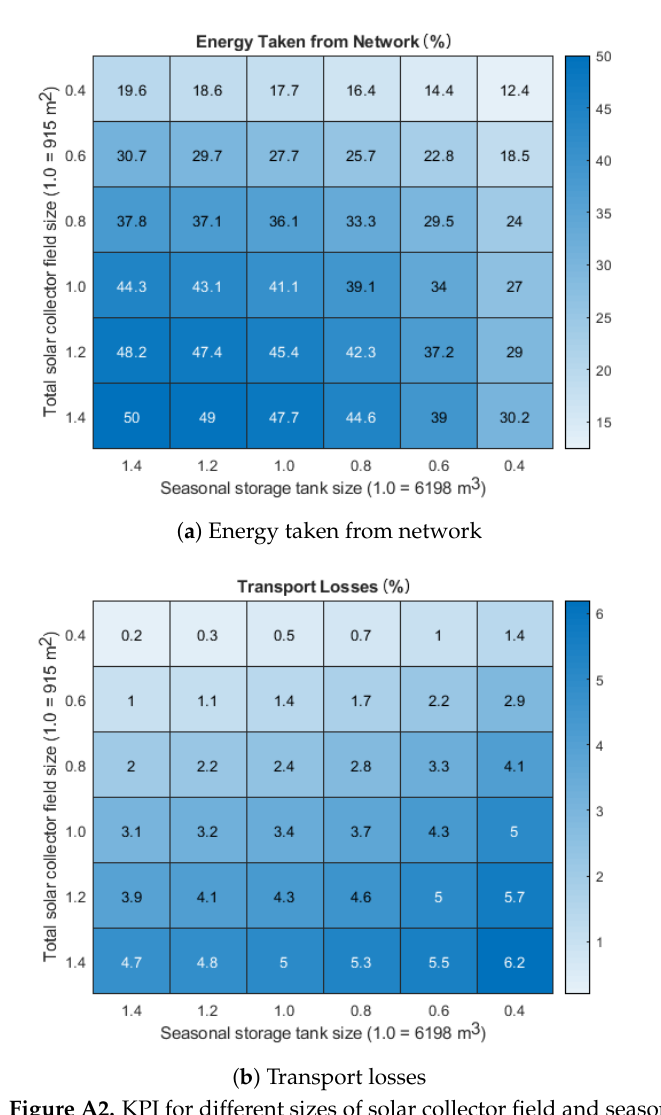
Figure A2. KPI for different sizes of solar collector field and seasonal storage